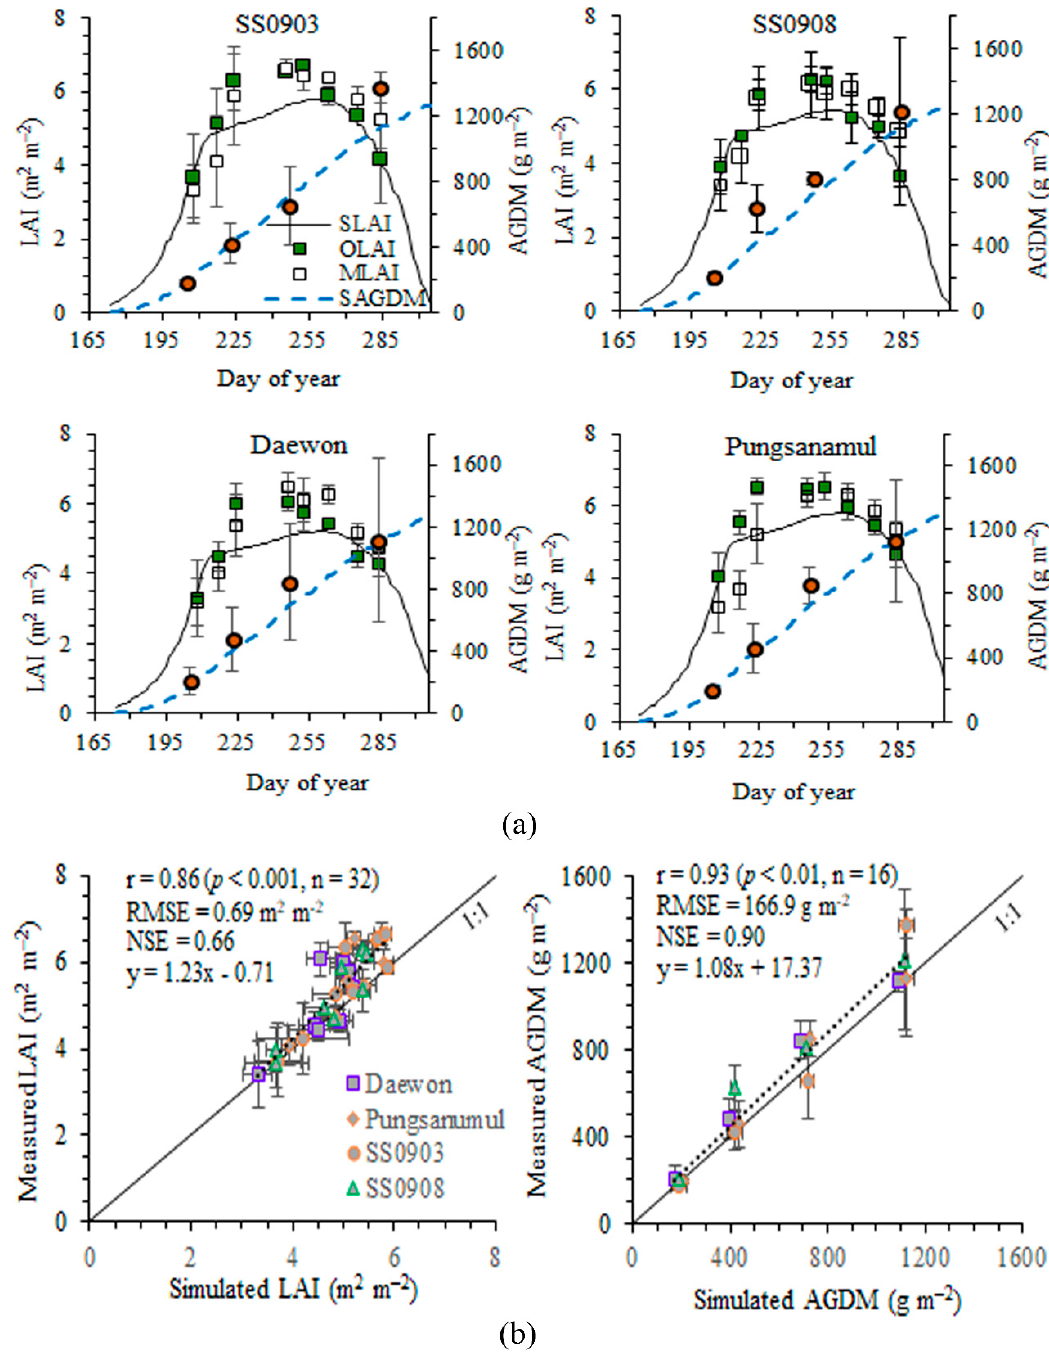
Figure 4. Model calibration: Simulated (S) and measured (M), observed (O) LAI and above-ground dry mass (AGDM) for four soybean germplasms or cultivars, SS0903, SS0908, Daewon, and Poongsanamul based on the vegetation index input option ( a ), and comparisons between S and M values for LAI and AGDM ( b ). Data were obtained at Chonnam National University, Gwangju, South Korea in 2017. Vertical and horizontal error bars represent the standard deviations ±1 SD of the mean values. The solid and dotted lines in the panel ( b ) represent the ratio 1:1 and a linear fit, respectively. NSE, RMSE, and r denote Nash-Sutcliffe efficiency, root mean square error, and Pearson’s correlation coefficient, respectively.